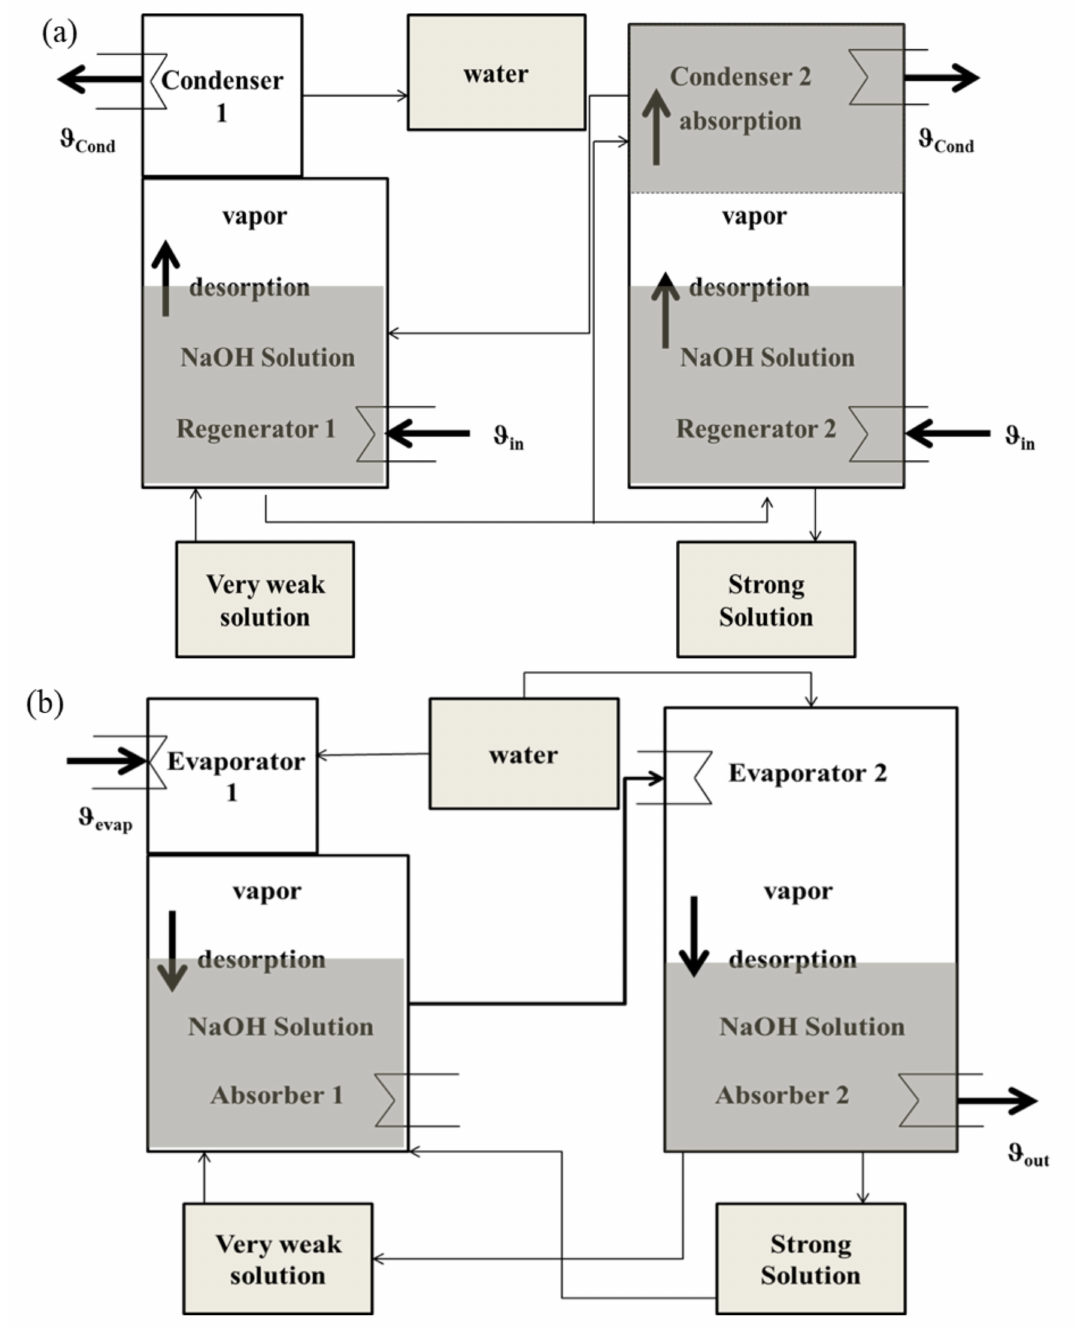
Figure 15. Double-stage absorption cycle: ( a ) Charging; ( b ) Discharging [104]. Absorption TES systems have the potential to store energy from renewable energy sources. To present a clear view, this section has provided detailed information on systems based on the absorption storage mechanism, including the thermodynamic absorption cycles and an integrated framework. Some of the critical factors related to absorption storage systems were identified through the literature review. The thermodynamic cycle design influences the energy storage density, thermal power output, and system design, which can be improved by switching from the conventional absorption cycle to a novel absorption cycle. The triple-stage absorption cycle is a novel approach to enhance the energy density of the system; it outperforms the conventional absorption cycle. The absorption system linked with the storage system provides more flexibility to be run